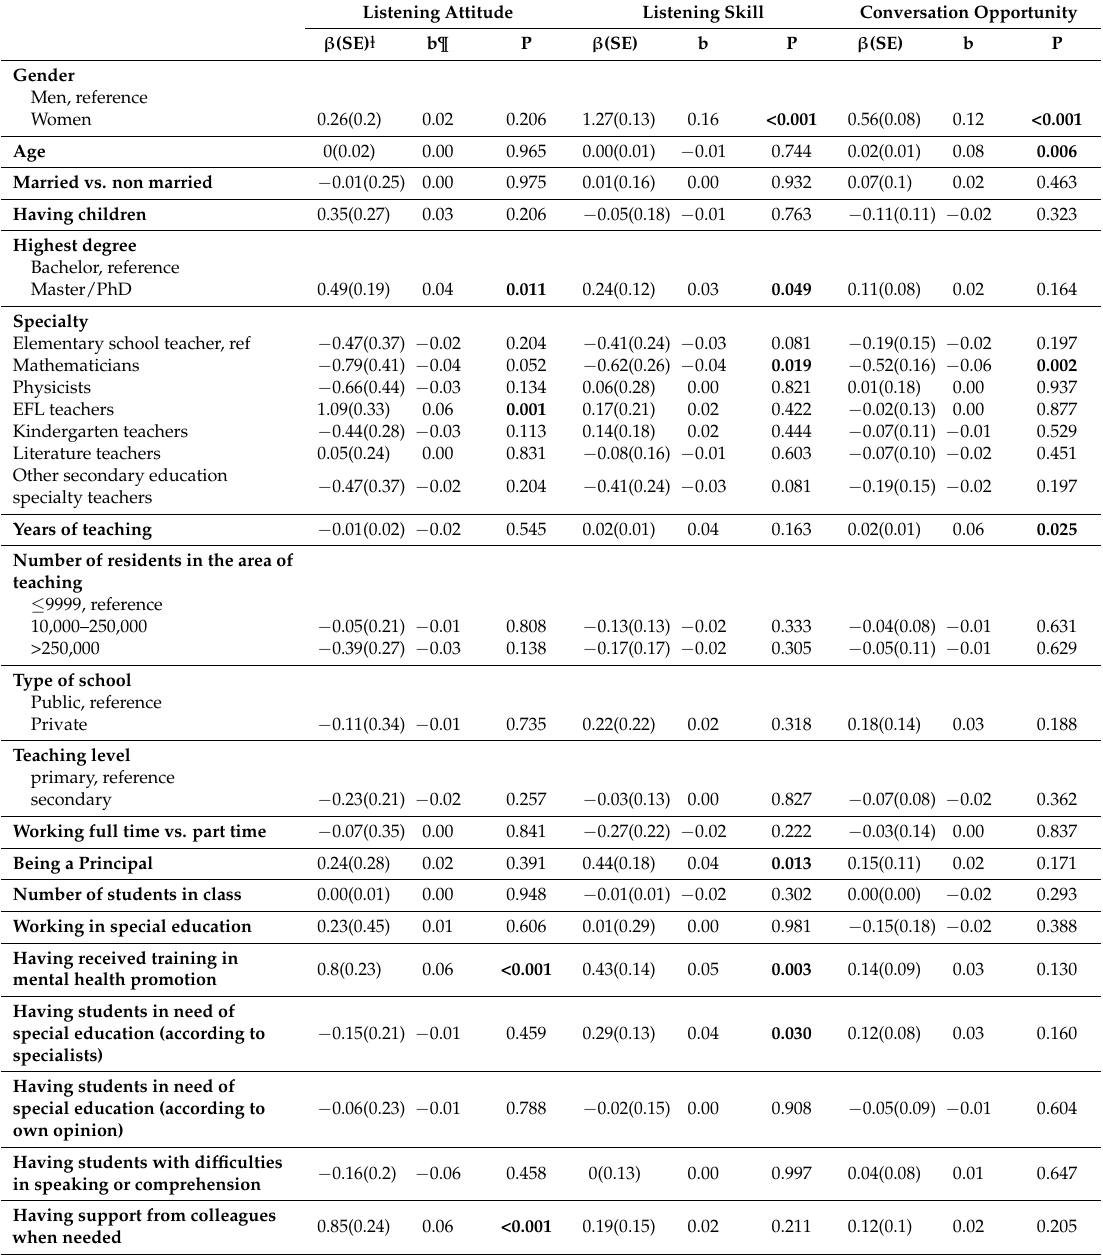
Table 4. Results from multiple linear regression analysis for ALAS